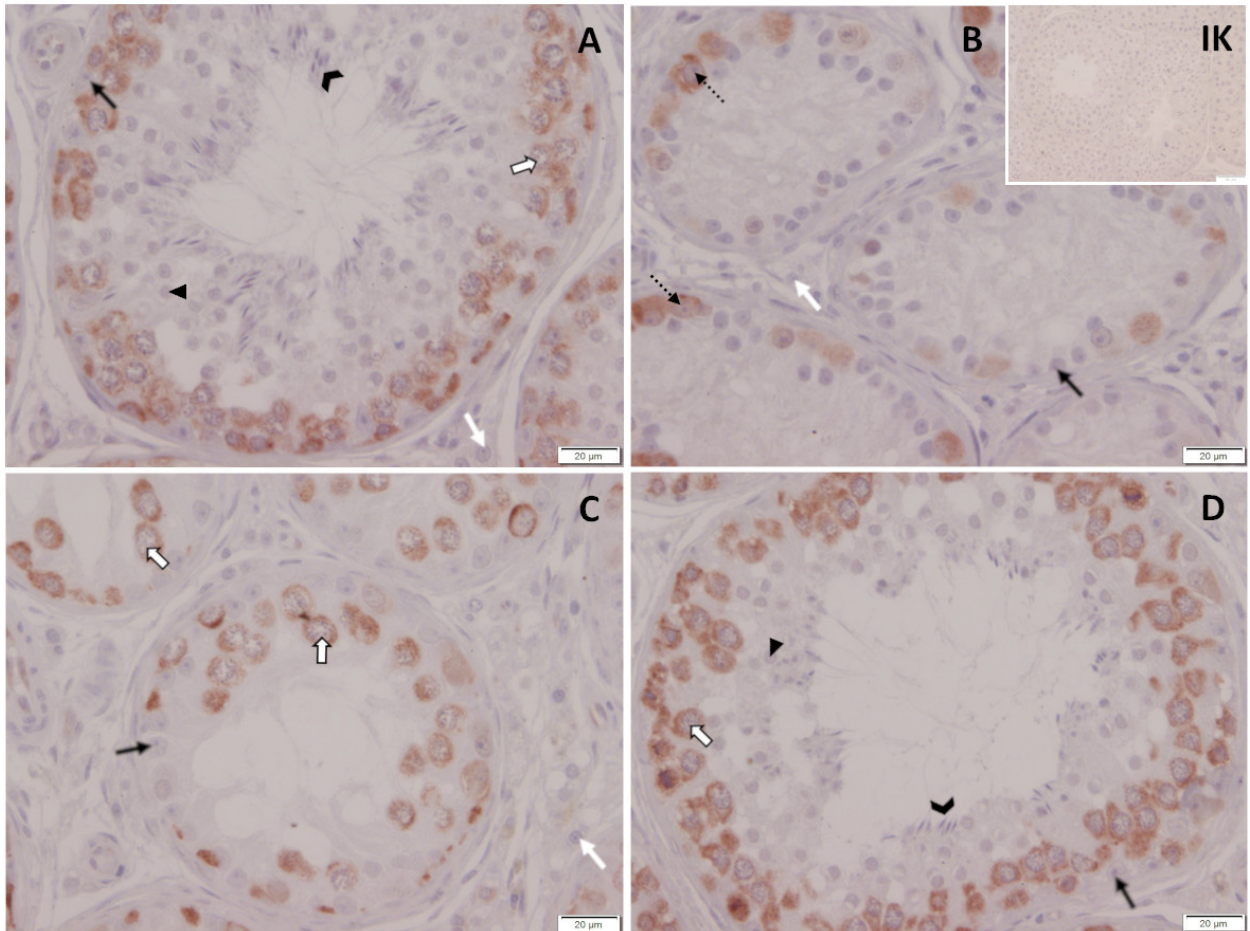
on D147 after treatment; Figure 14. Immunopositive staining of testicular tissues against DAZL. ( A ) Saline-treated control